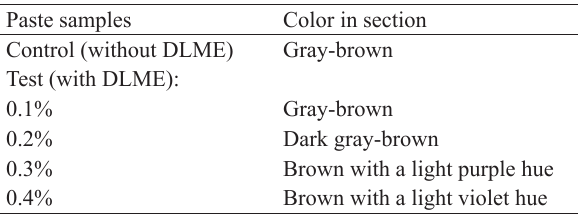
Table 2 Paste color with different concentrations of dry lingonberry marc extract Paste samples